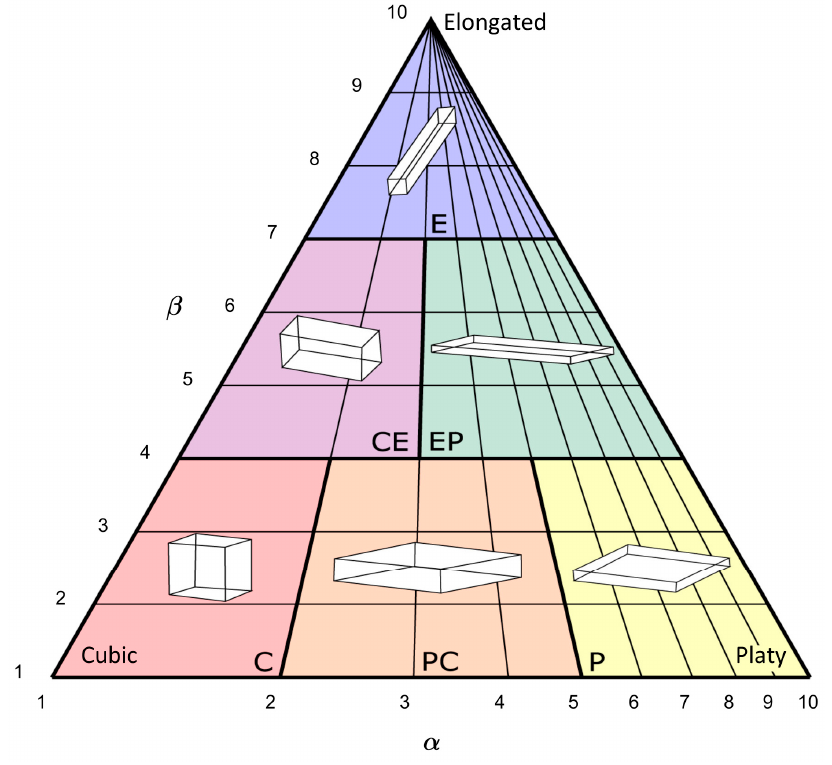
Figure 8. Block shape classification diagram based on the parameters α and β .